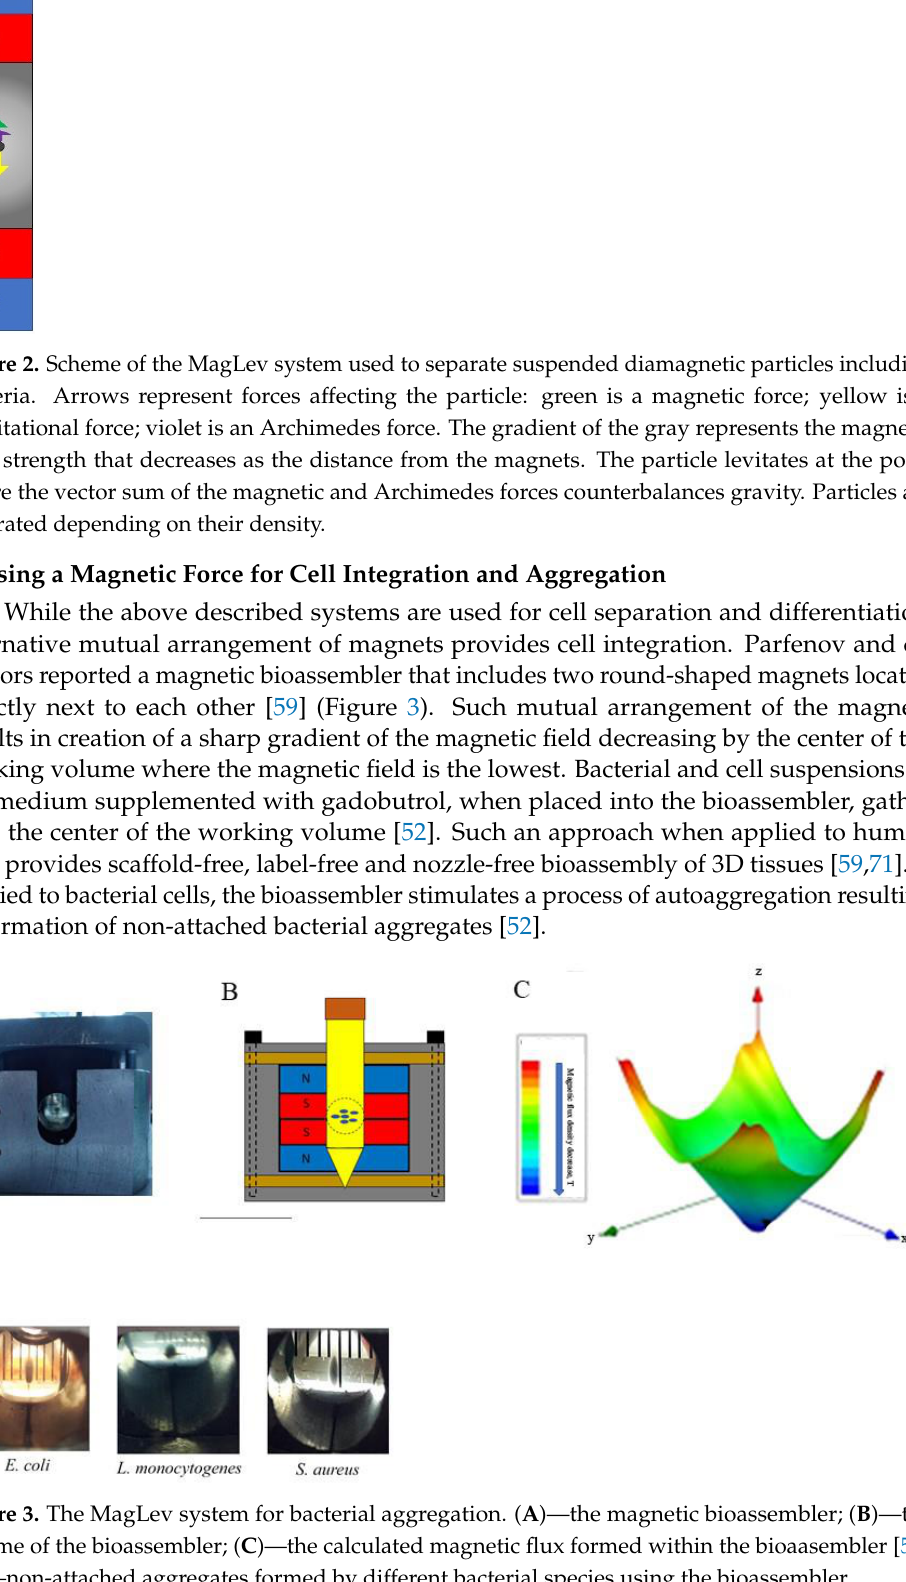
Figure 3. The MagLev system for bacterial aggregation. ( A )—the magnetic bioassembler; ( B )—the scheme of the bioassembler; ( C )—the calculated magnetic flux formed within the bioaasembler [52]; ( D )—non-attached aggregates formed by different bacterial species using the bioassembler. Bacterial flocculation and autoaggregation within the liquid volume is a process typical for natural aquatic ecosystems, which is used industrially for waste-water treatments